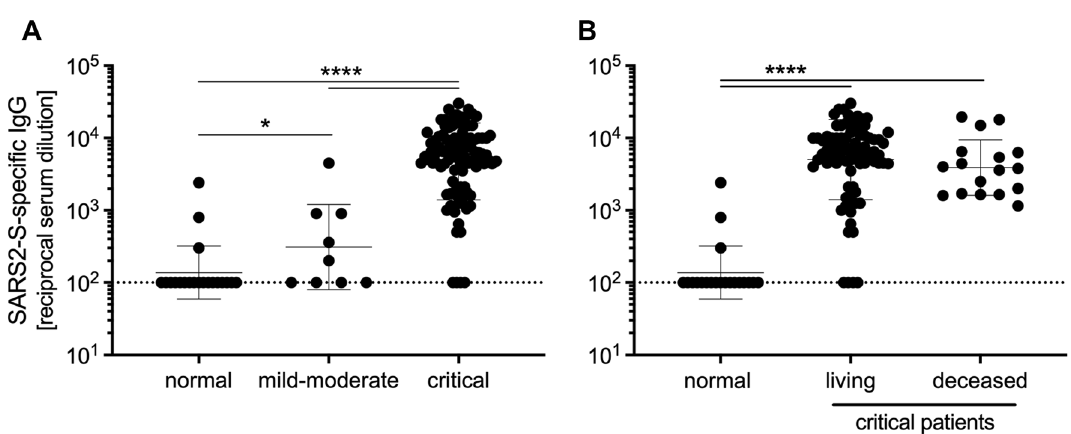
Figure 3. Critical COVID-19 induces high titers of anti-SARS-CoV-2 IgG. ( A ) IgG titers specific to SARS- CoV-2 spike receptor-binding domain for COVID-19 and normal serum samples. ( B ) IgG titers of critically infected COVID-19 patients who either recovered from infection (living) or failed to recover (deceased), alongside 20 uninfected (normal) patients. Geometric mean and geometric SD are shown. Statistically significant differences as determined by Mann–Whitney test are indicated as p < 0.0001 (****), and p < 0.05